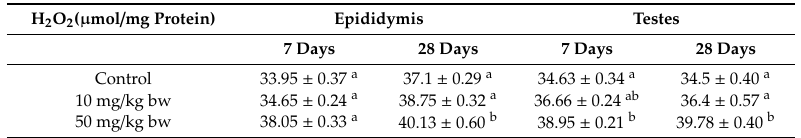
Table 10. Effects of sub-dermal administration of Ag-NP on H 2 O 2 generation in testes and epididymis of experimental rats. H 2 O 2 (μmol/mg Protein)